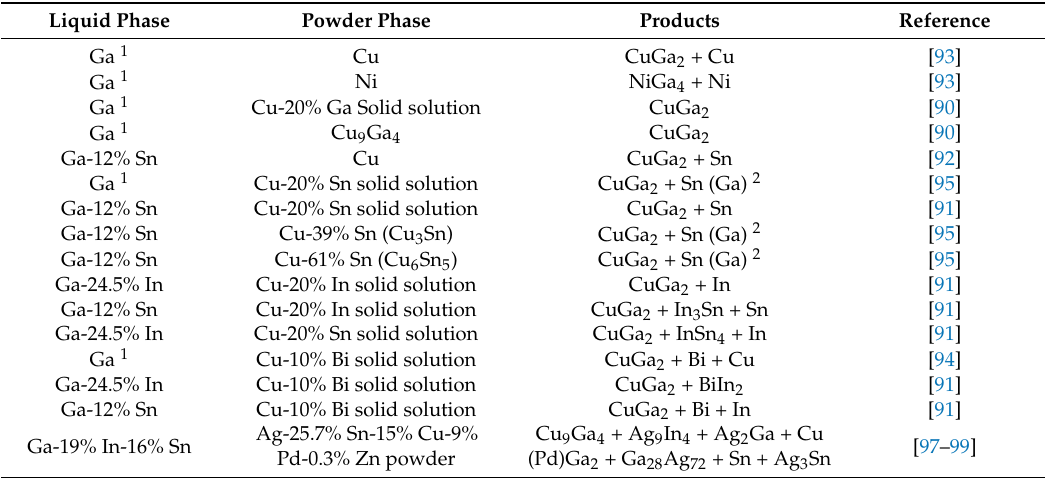
Table 2. Summary of reactions between liquid Ga-based alloys and metal